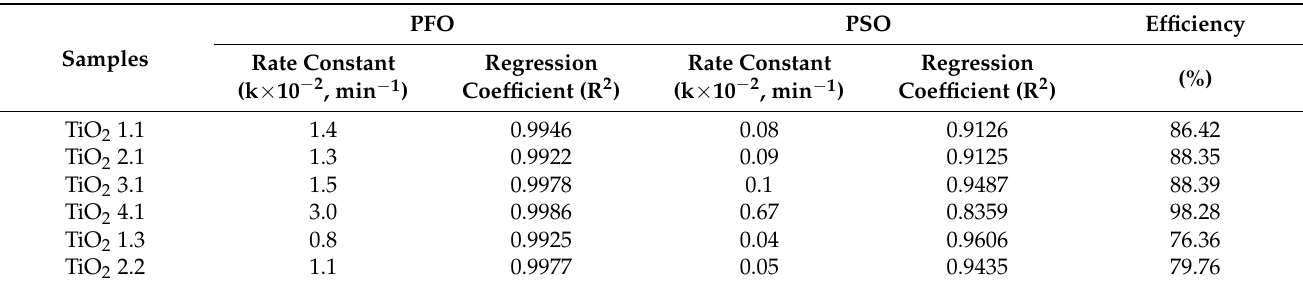
Table 3. The PFO and PSO kinetic rate constants and corresponding regression coefficients resulted in CR dye photodegradation reaction over the synthesized titania